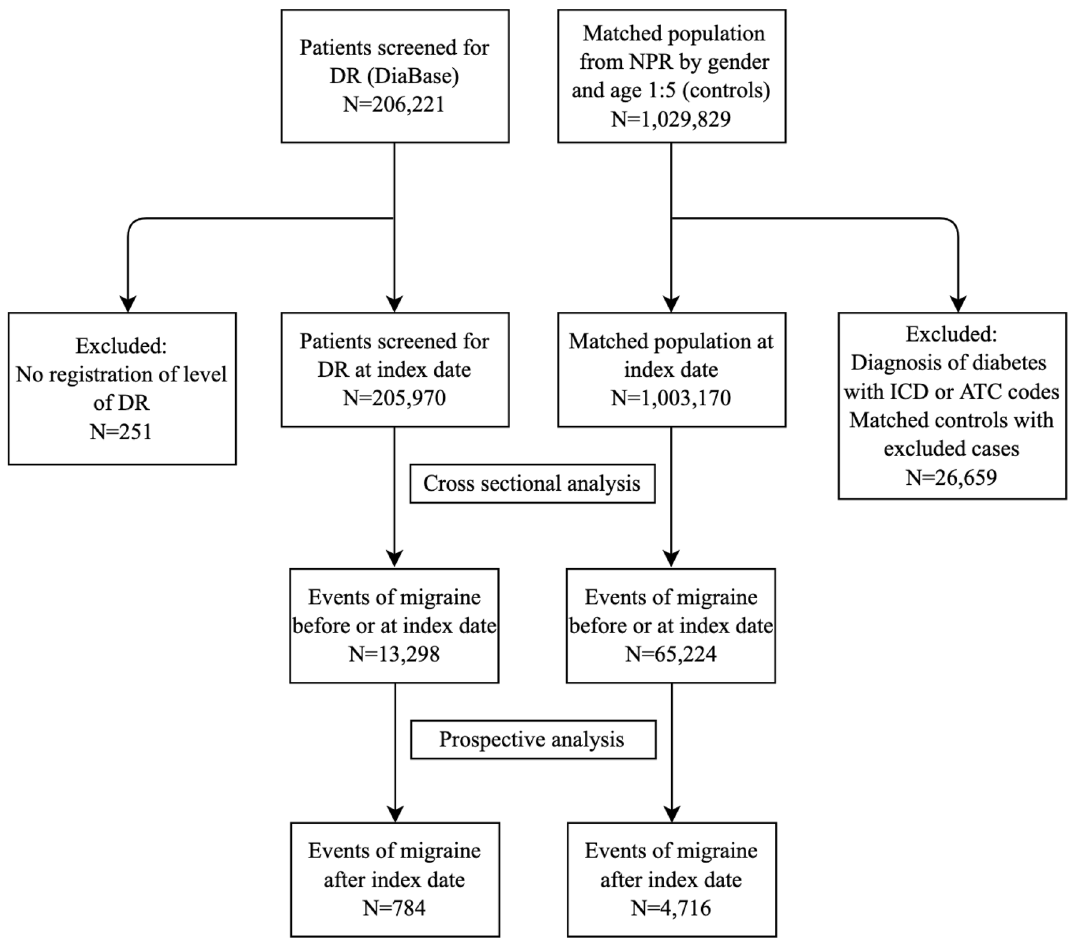
Figure 1. Flow chart of inclusion and exclusion. Flowchart showing patient progression in the study. Diabase: Danish Registry of Diabetic Retinopathy; DR: Diabetic Retinopathy; CPR: The Danish Civil Registration System; ICD: International Classification of Disease; ATC: Anatomical Therapeutic Chemical Classification System.